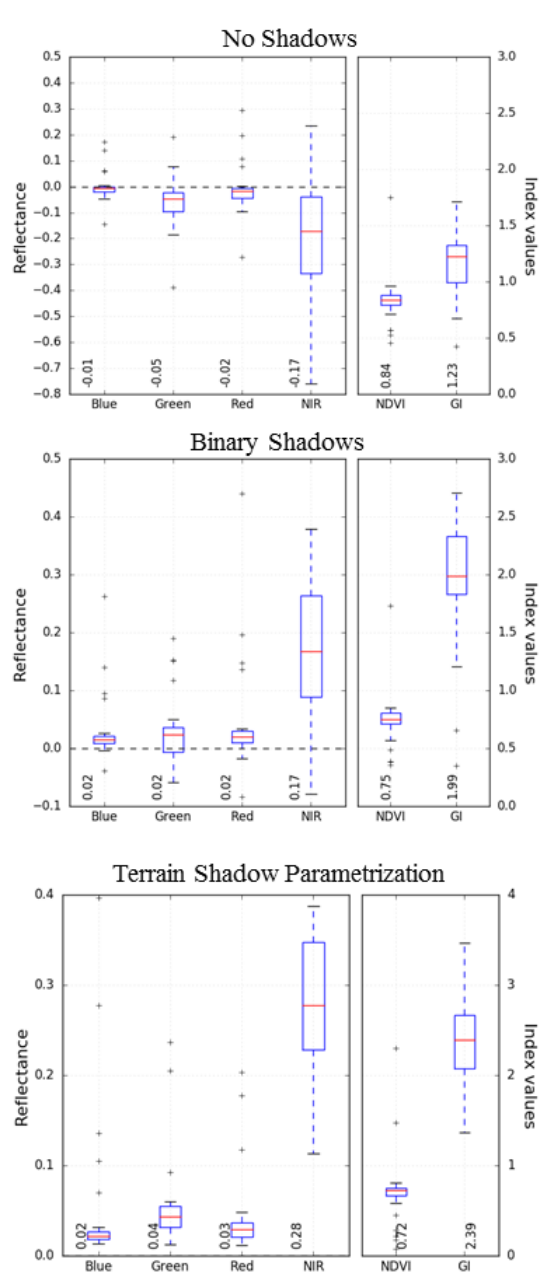
Figure 2: Comparison of the three shadow implementation meth- ods for the corrected larch signal on August 3 rd , 2015.